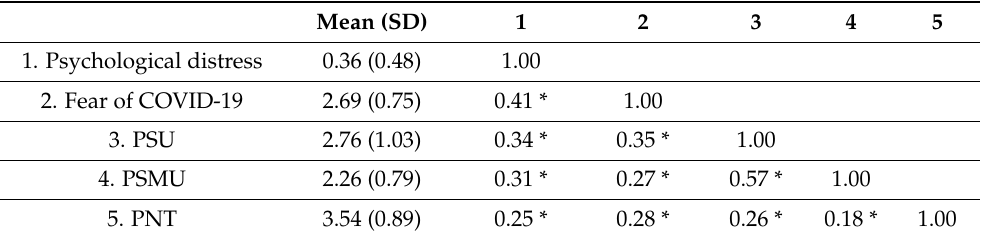
Table 2. Descriptive statistics and Pearson correlation matrix of the variables of